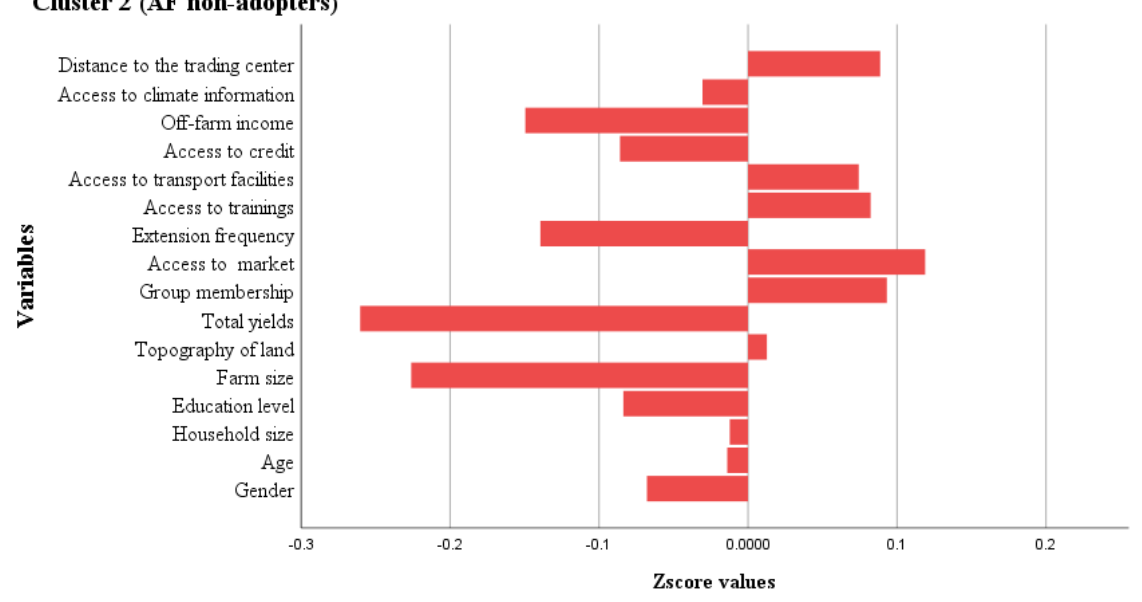
Figure 4. The variables’ distance from the AF non-adopters’ cluster center.